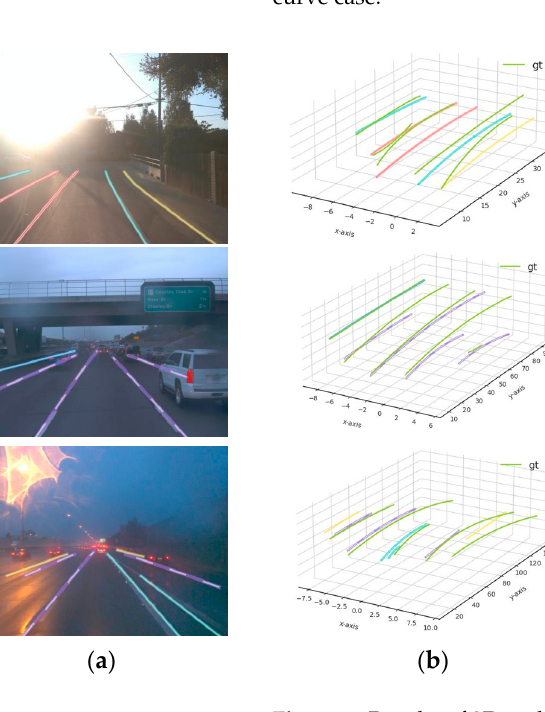
Figure 2. Results of 2D and 3D lanes obtained from the proposed method: ( a ) 2D results of up and down case; ( b ) 3D results of up and down case; ( c ) 2D results of curve case; ( d ) 3D results of curve case.